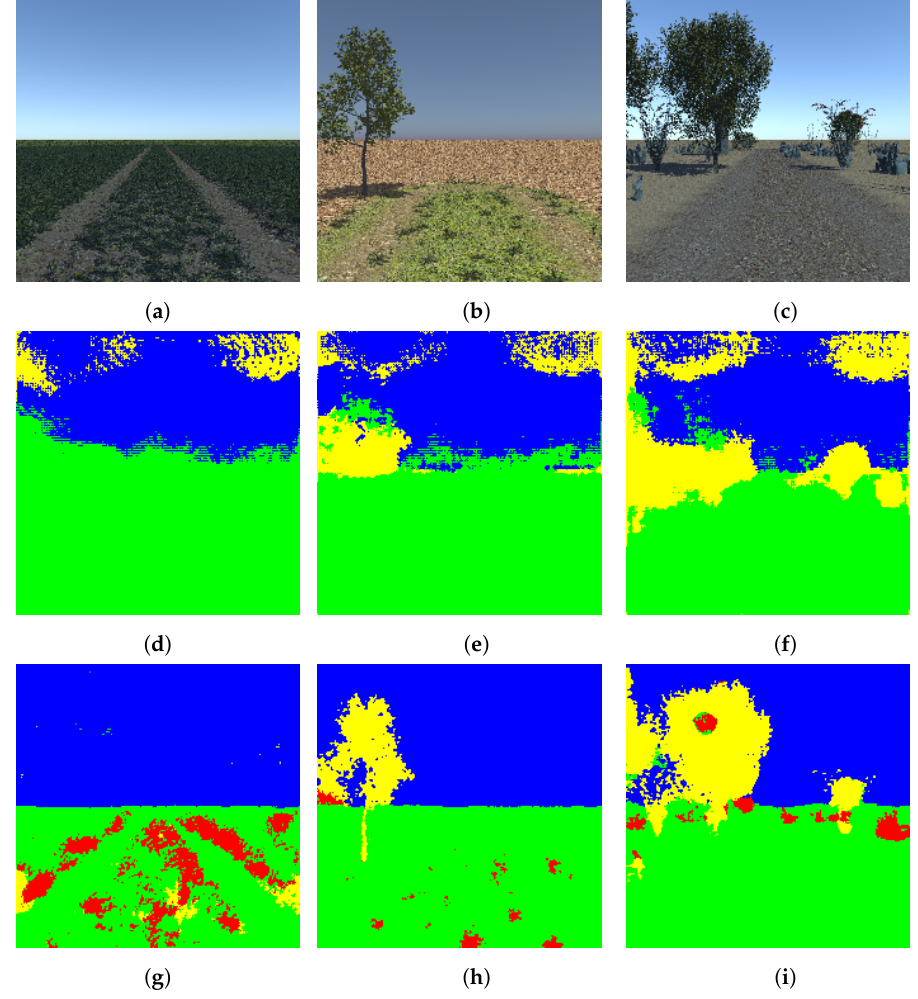
Figure 9. Segmentation of the four-class random dataset ( a – c ): test images, ( d – f ): segmented images using DeconvNet, ( g – i ): segmented images using proposed light-weight network. Note that the color code for classes is: green: ground, red: vegetation, yellow: tree, blue: sky. Best viewed in